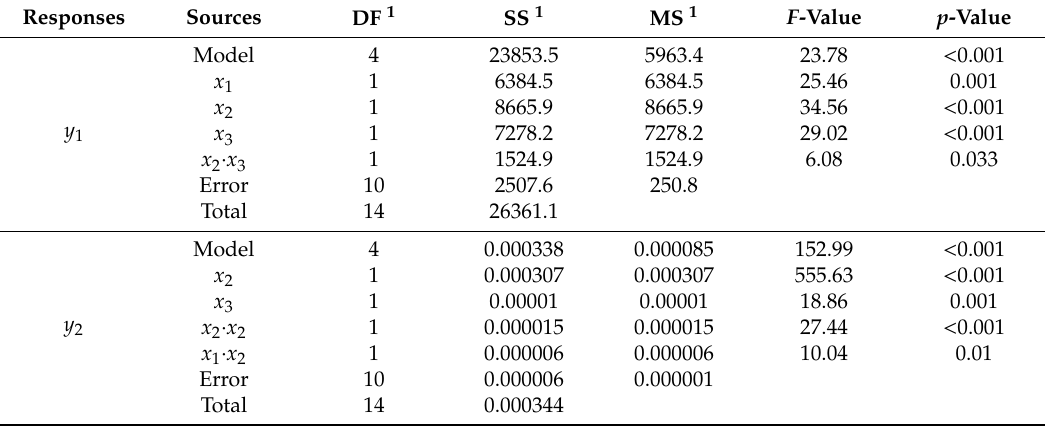
Table 2. Response surface regression of viscosity ( y 1 ) and drying rate constant ( y 2